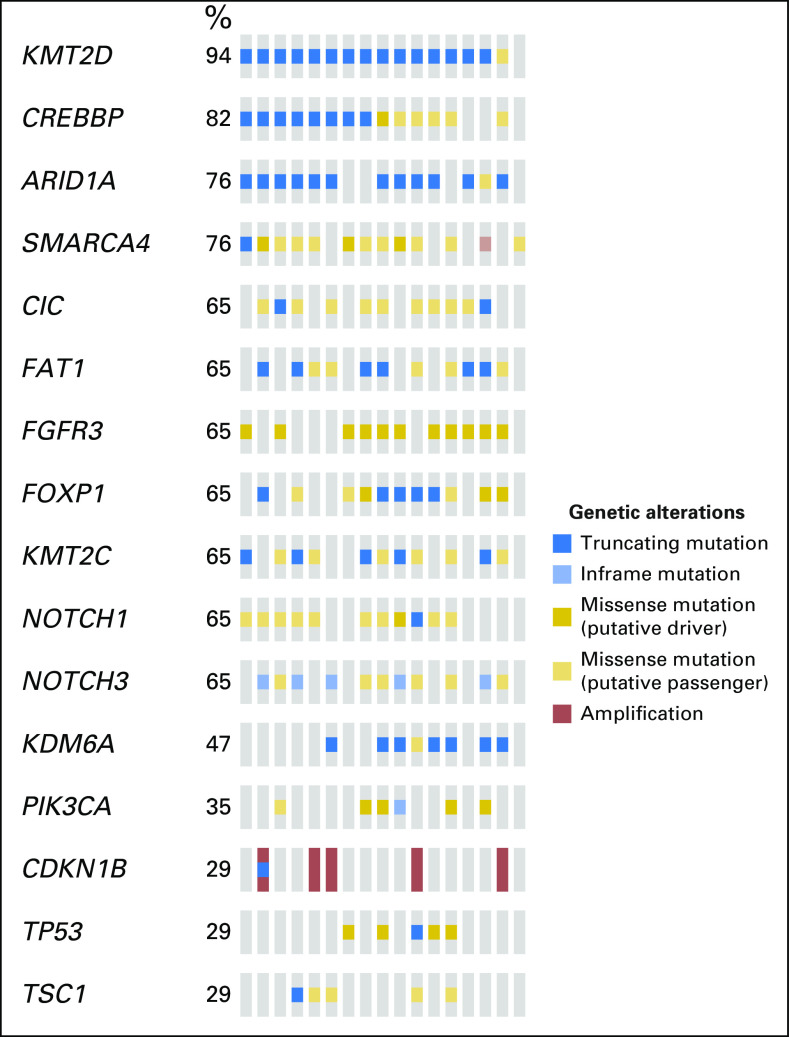
Oncoprint of the most frequent genes altered in the Lynch cohort.